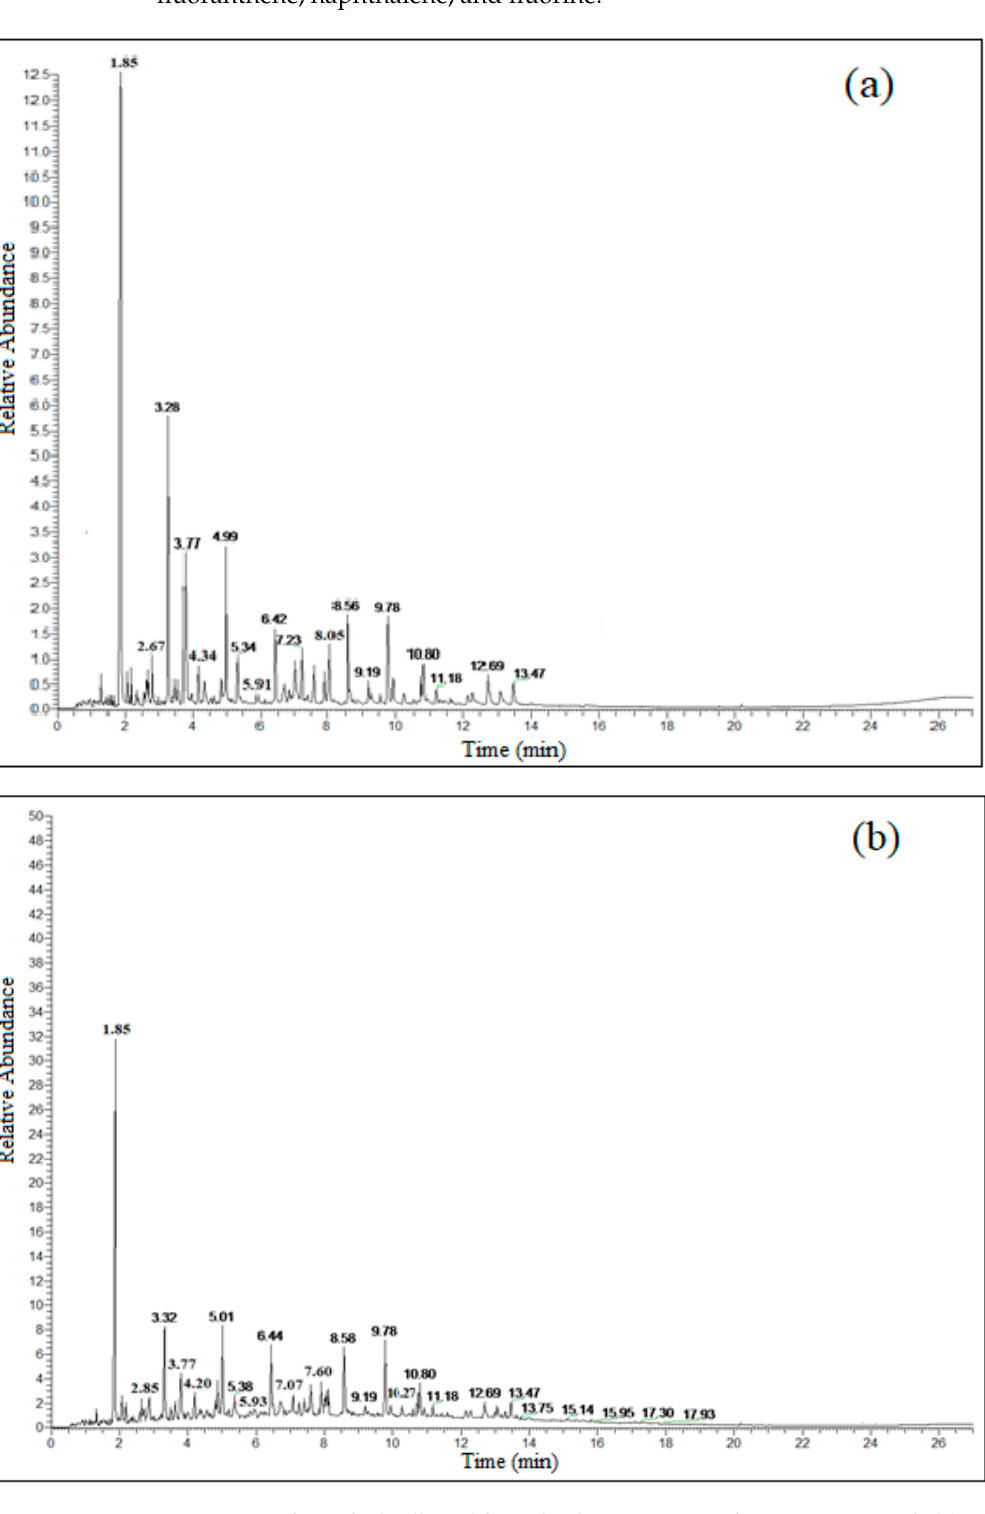
Figure 8. GC/MS of oil collected from the decomposition of pomegranate peels ( a ) without a catalyst; ( b ) with a catalyst.